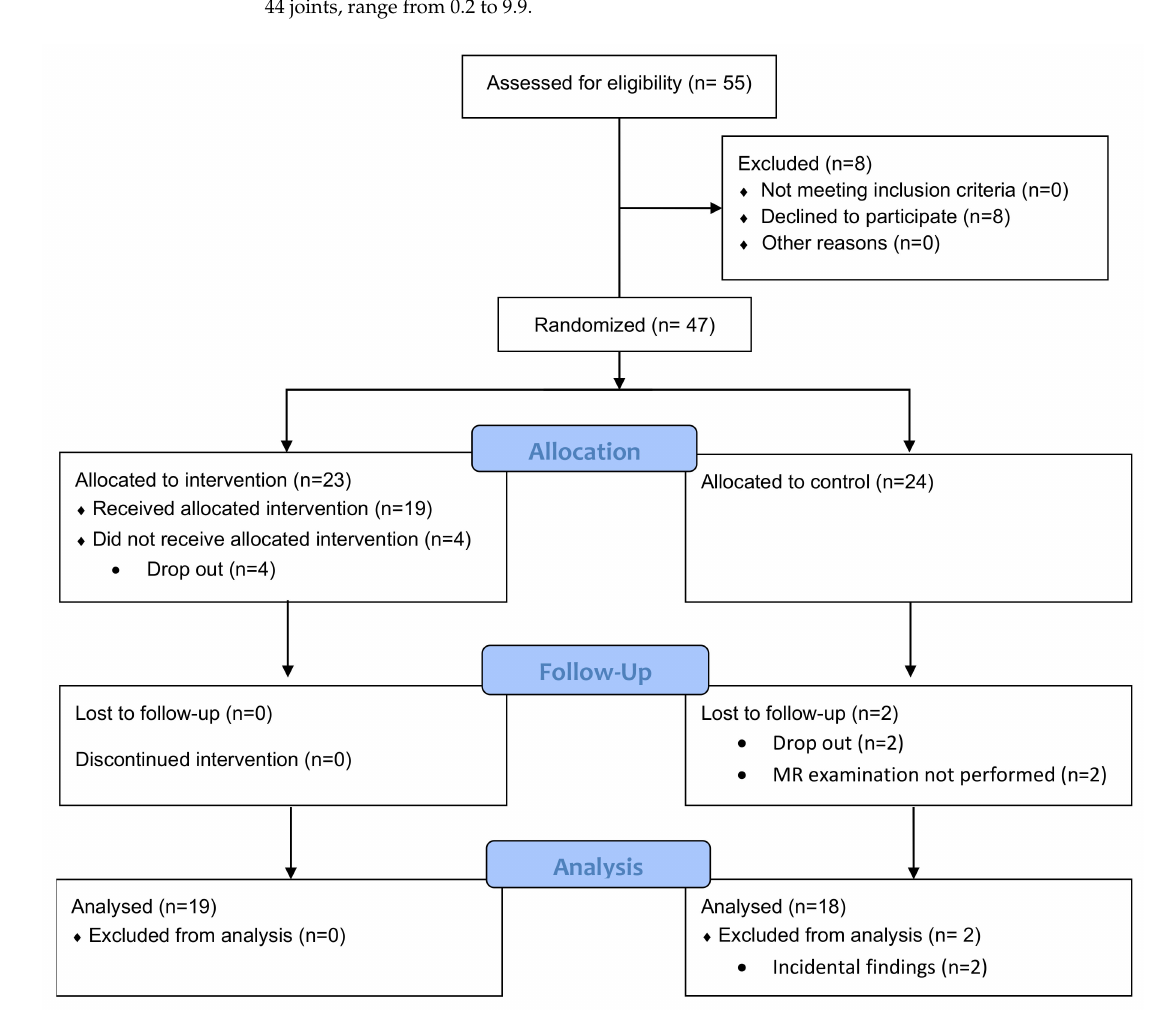
Figure 1. Flow chart of patient inclusion, follow-up, and